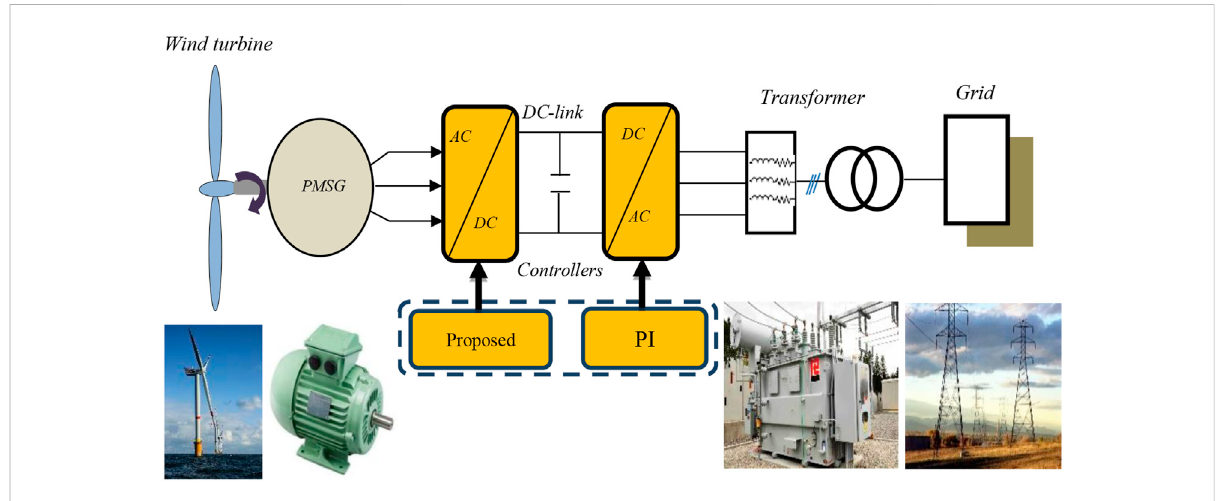
FIGURE 1 Wind power